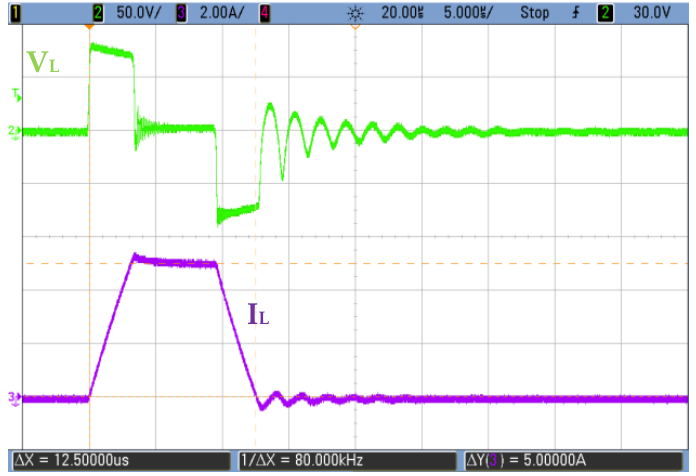
Figure 16. Trapezoidal current (Channel 3, purple) and voltage pulse (Channel 2, green) applied to the transducer by means of using full-bridge+buck converter .